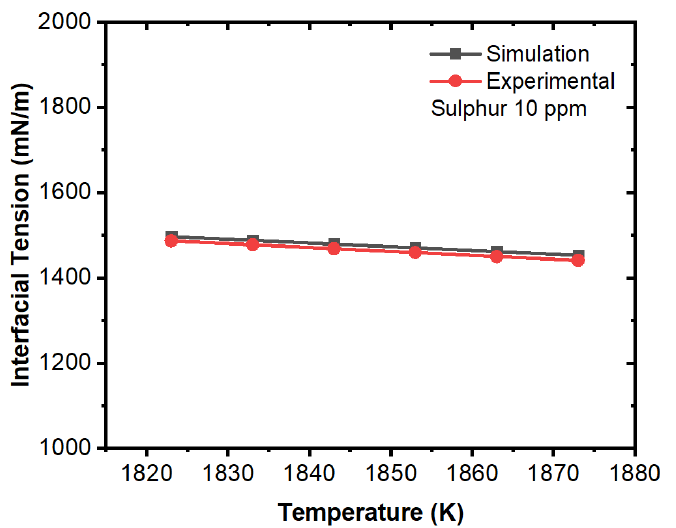
Figure 15. Comparison of experimental and simulation results of interfacial tension with respect to temperature (sulfur: 10 ppm, experimental work by Jeong et al. [26]).